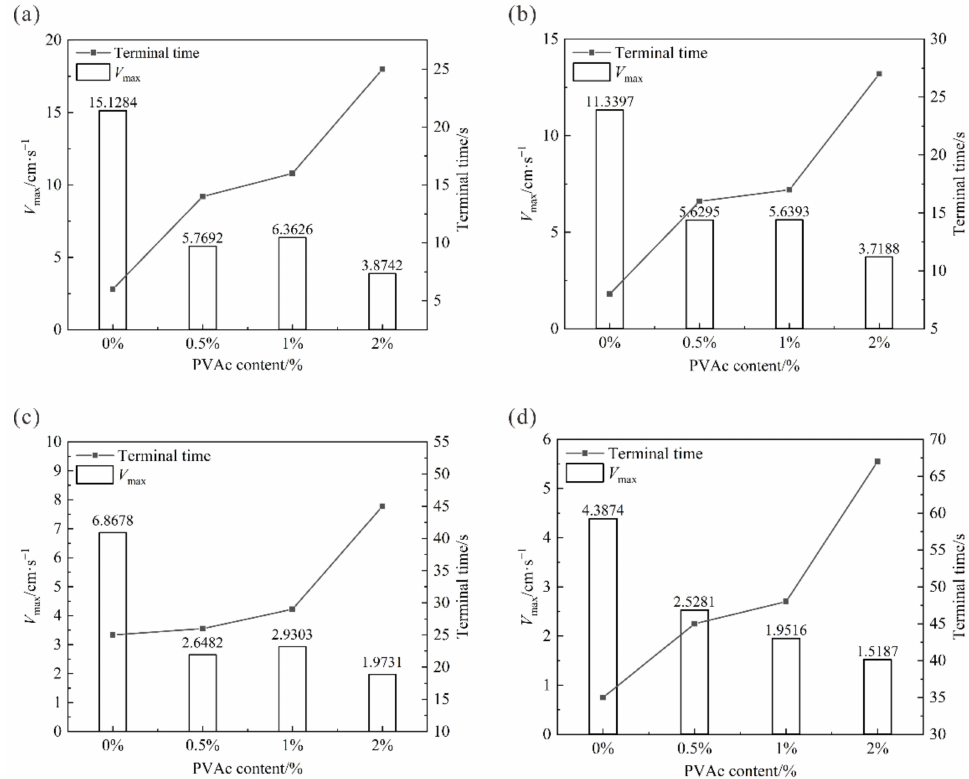
Figure 8. Sliding time and peak speed of PVAc-reinforced clay at the moisture content of ( a ) 45%, ( b ) 40%, ( c ) 35%, and ( d )